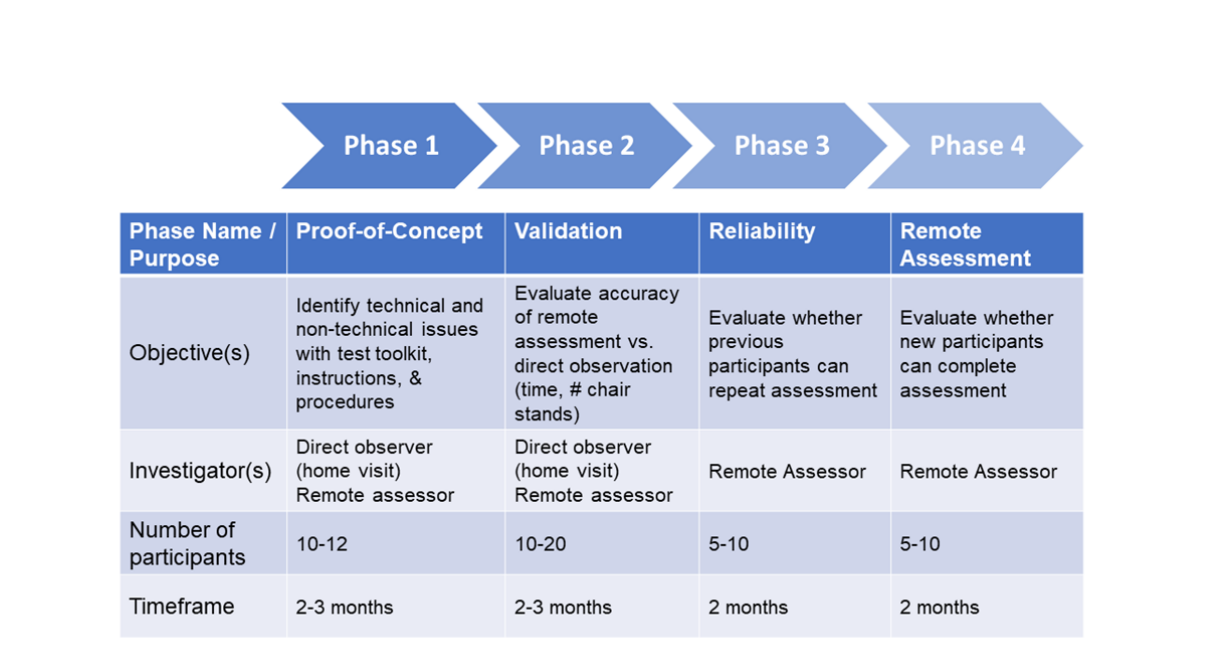
Figure 1. Phases of the remote assessment